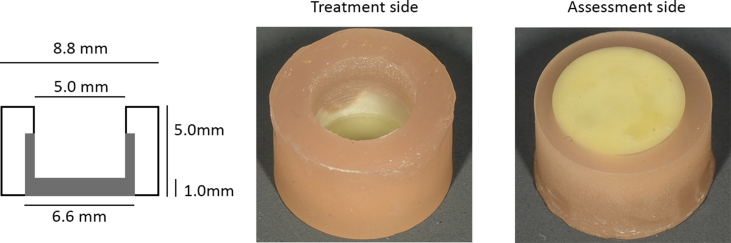
Technical drawing (left panel) and representative photographs of the model used in this study. Human dentin from the roof of the pulp chamber of extracted sound third molars was embedded in methacrylate. A reservoir for the blood and the subsequent treatment (Treatment side, middle panel) was drilled from the pulpal side of the dentin, whilst the coronal aspect was polished for color assessment (Assessment side, right panel).